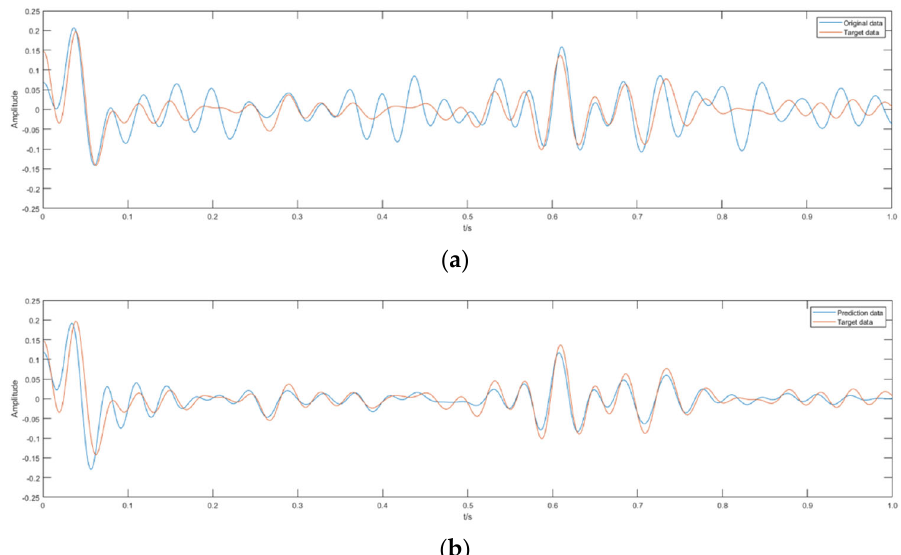
Figure 11. Comparison of trace waveforms. ( a ) Single-channel comparison of passive seismic records with short periods before processing vs. passive seismic records with long periods. ( b ) Single-channel comparison of passive seismic records with short periods after processing vs. passive seismic records with long periods.